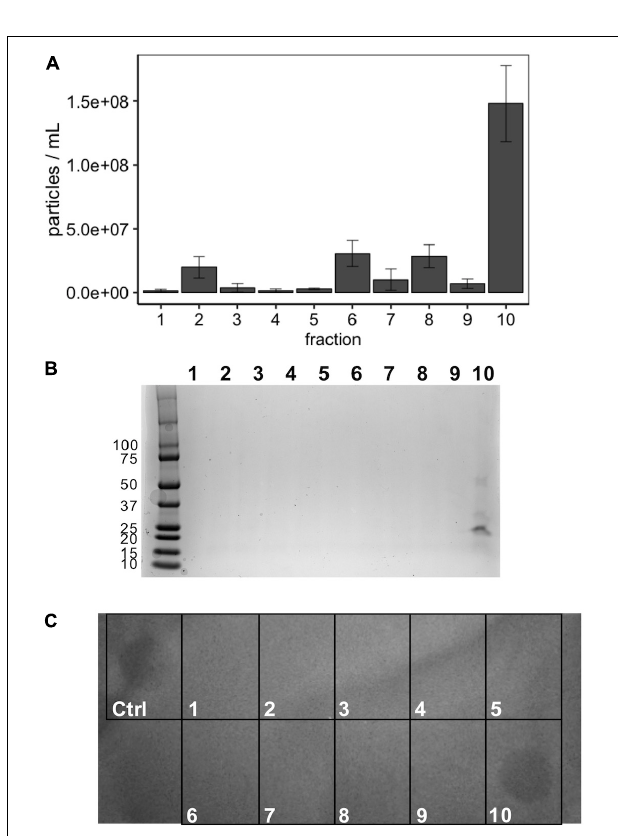
FIGURE 7 | Optiprep purification of MVs. (A) Following fractionation MV concentration (particles/mL) was determined using NanoSight from 1:100 diluted fractions in PBS. (B) Coomassie stain of SDS-PAGE gel of the 10 Optiprep fractions. (C) Spot-on-lawn of L. delbrueckii following Optiprep fractionation; control (ctrl) is the input MVs prior to fractionation.